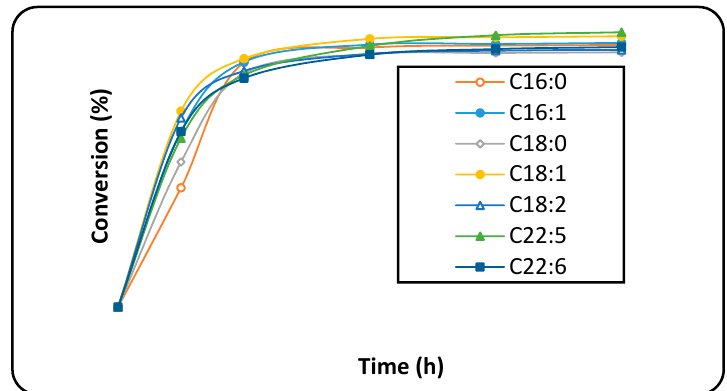
Figure 15. Conversion of different FFAs for corresponding methyl ester synthesis. Conditions: 1.5% Novozym435, 250 rpm, 45 °C, 3Å molecular sieves (1.2:1, w/w, based on oil weight), Molar ratio of